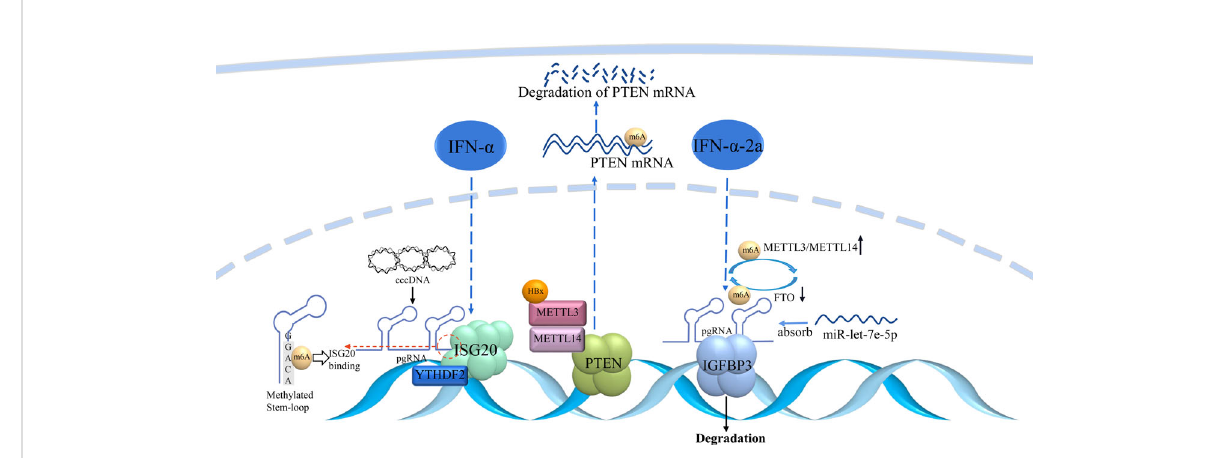
FIGURE 4 m6A modulation involved in IFN